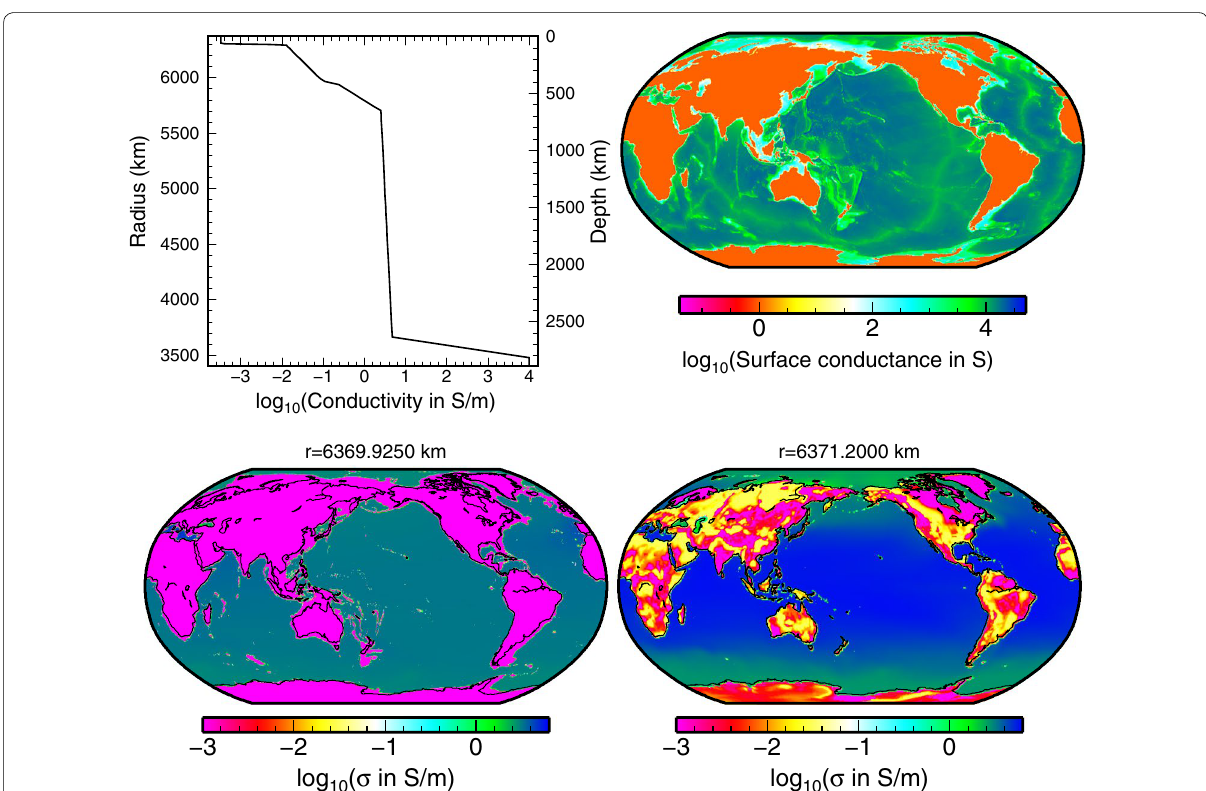
Fig. 2 Electrical conductivity. Top left: The 1-D electrical conductivity profile of the Earth’s mantle after Grayver et al. (2017). Top right: Map of the electrical surface conductance of the oceans and continents used in the 2-D models. Bottom: Electrical conductivity map including the effects of seawater salinity, temperature, and the presence of sediments. Cross sections at 1.275 km depth (left) and at the surface